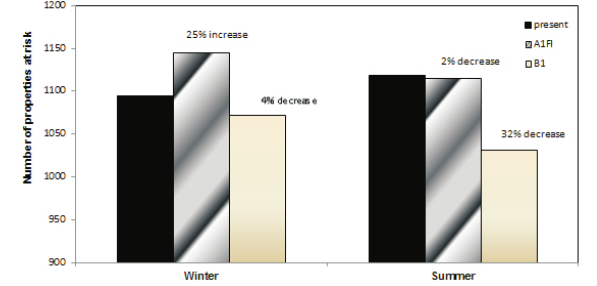
Figure 2: Surface flooding volume spilling from manholes in the present and future 2080s under scenario AFI (high) & B1 (low) for winter and summer. N.B. The percentage shown in the bar chart in- dicates a decrease and/or increase in design storm of the drainage system in the future compared with the baseline design storms.